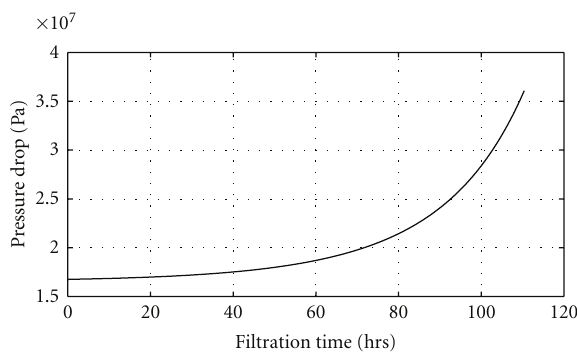
Figure 2: Representative pressure drop